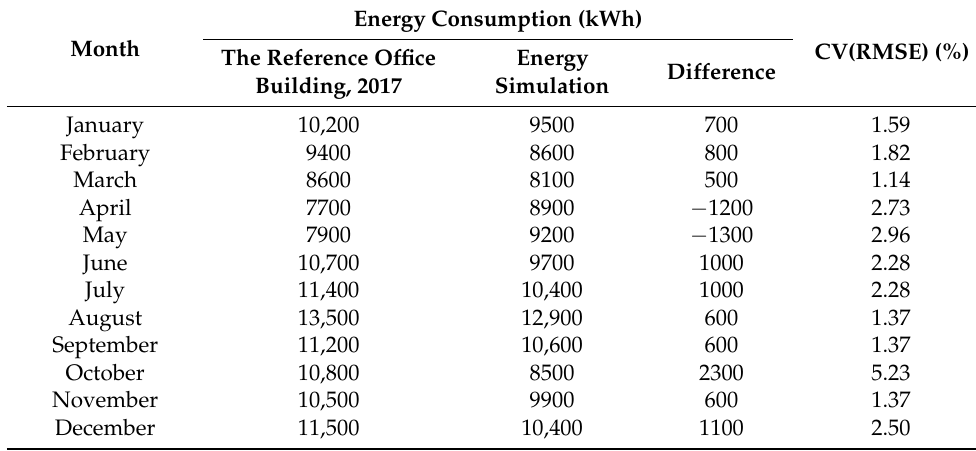
Table 4. The monthly energy consumption comparison.